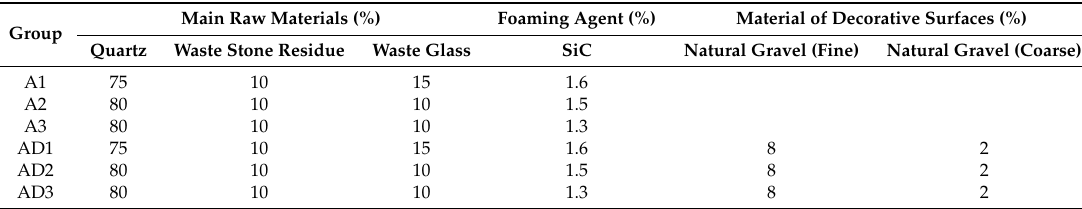
Table 2. Batch composition. Group A: Specimens without microcrystalline decoration surface; Group AD: Specimens with microcrystalline decoration surface; Numbers 1–3: Three different batch compositions of the main raw materials.